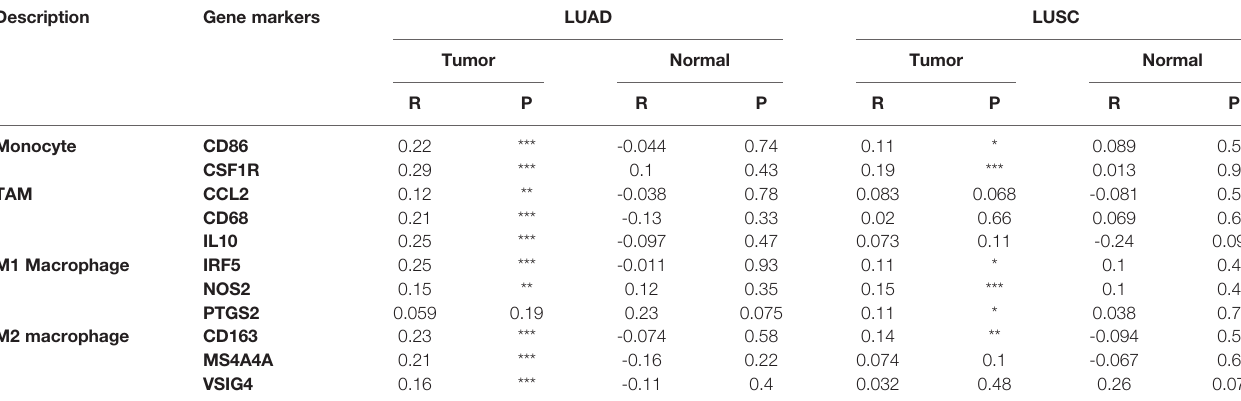
TABLE 2 | Correlation analysis between TTN and related genes and markers of monocyte and macrophages in GEPIA.